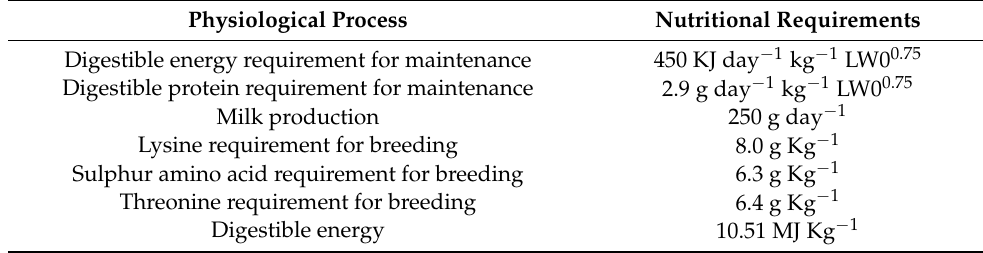
Table 1. Nutritional requirements of rabbits obtained from different studies